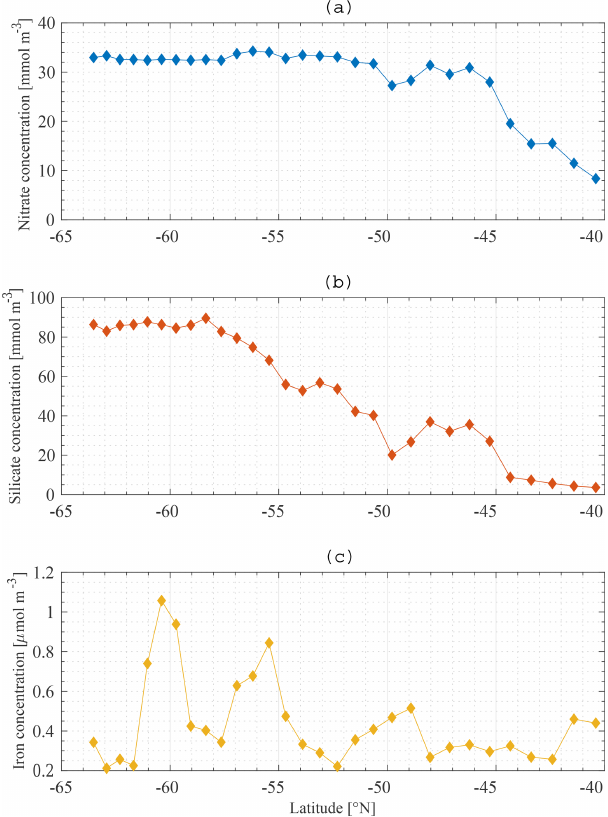
Figure 5. Nitrate (a) , silicate (b) and iron (c) lower-boundary con- ditions along the averaged model meridional